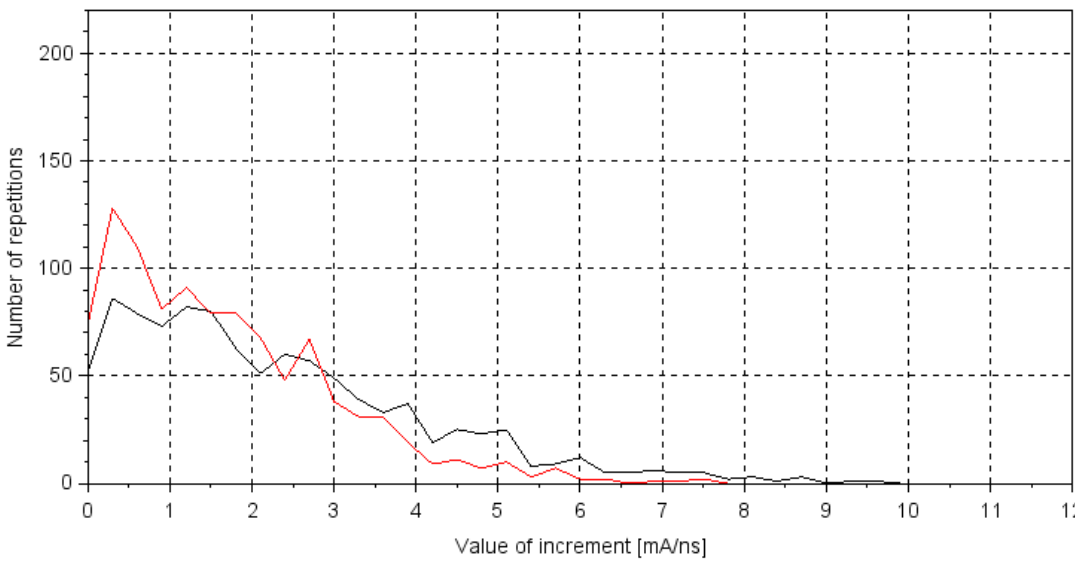
Figure 14. Figure showing 1 kpts decompositions of signals with no arc (conditions: shorted spark gap and current of 500 mA DC at each measurement).